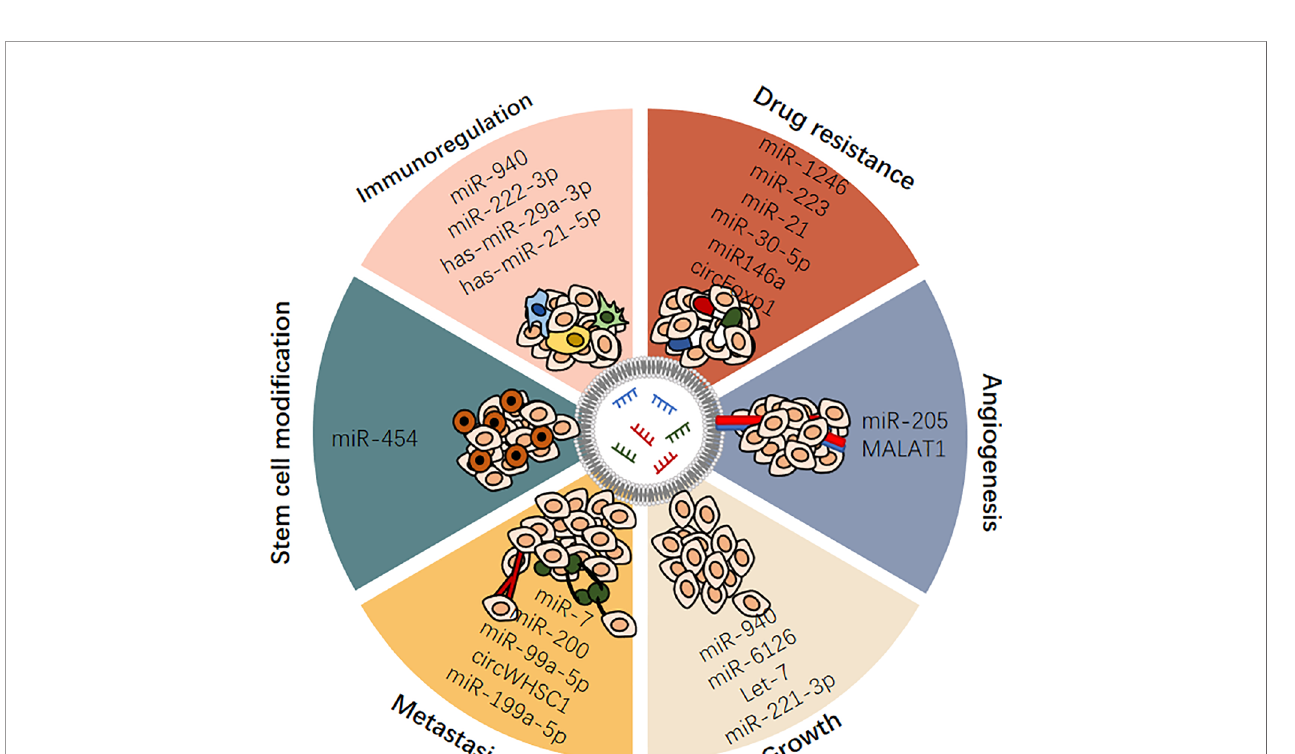
FIGURE 3 | Exosomal ncRNAs play important roles in regulating ovarian